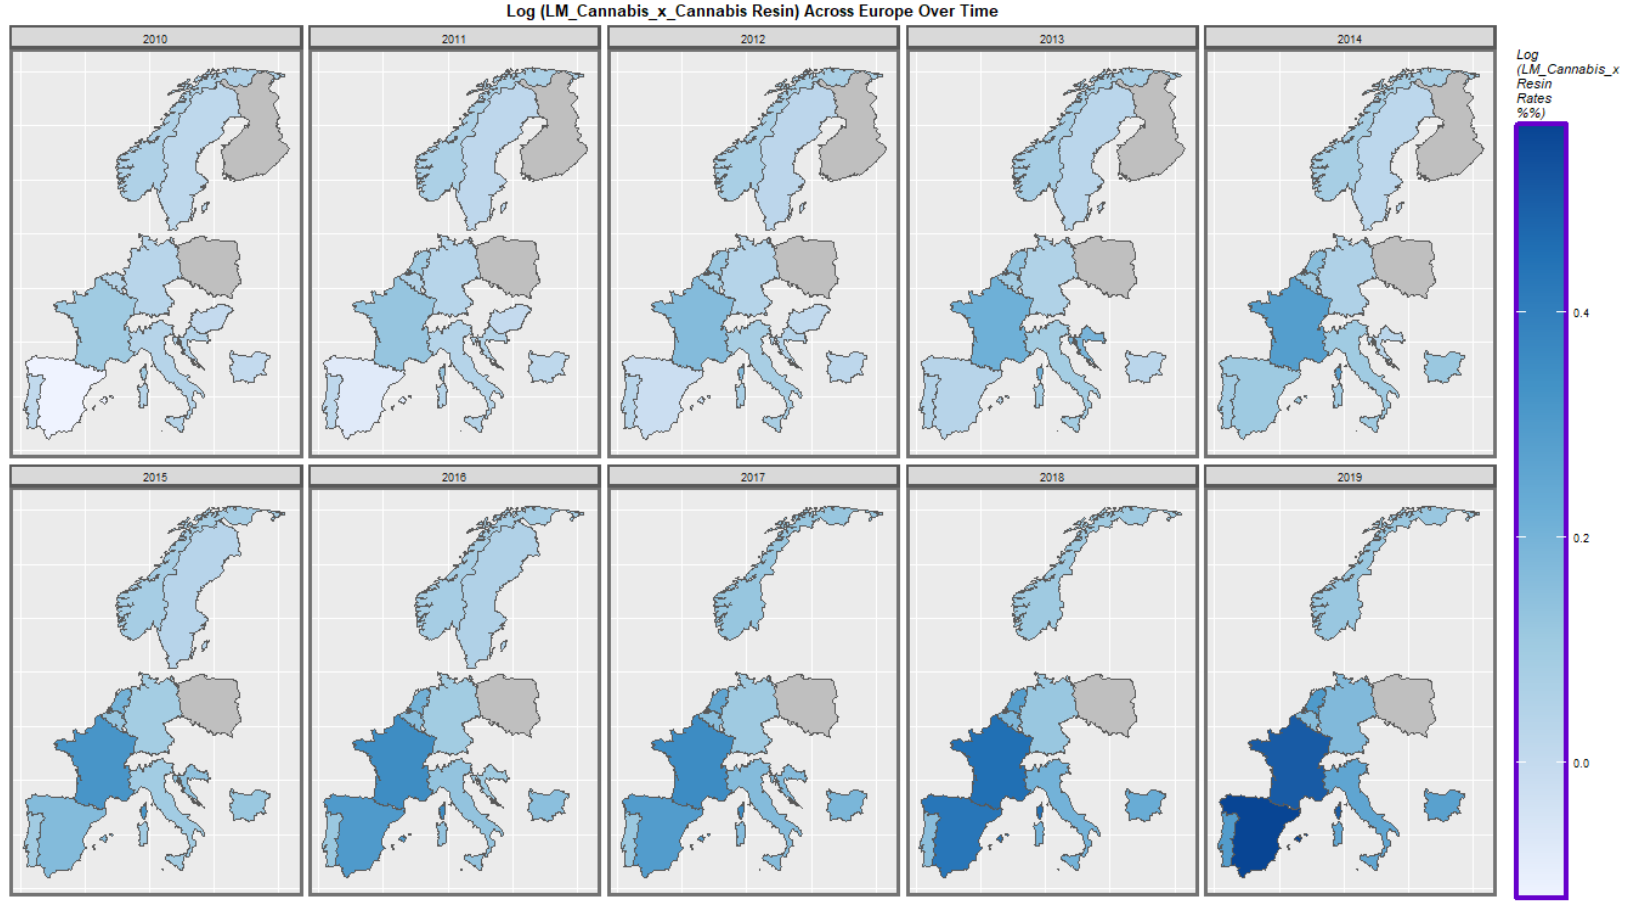
Figure 7. Time sequential map-graph of last month cannabis use: cannabis resin THC concentration across surveyed European nations over time.